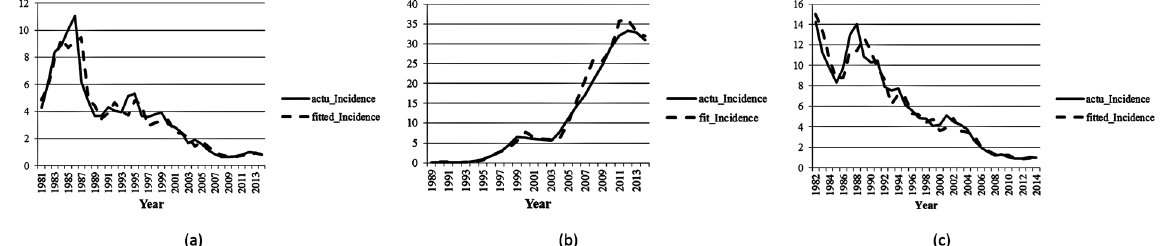
Figure 3. ( a ) The fitting plot for epidemic hemorrhagic fever; ( b ) The fitting plot for syphilis; ( c ) The fitting plot for typhoid